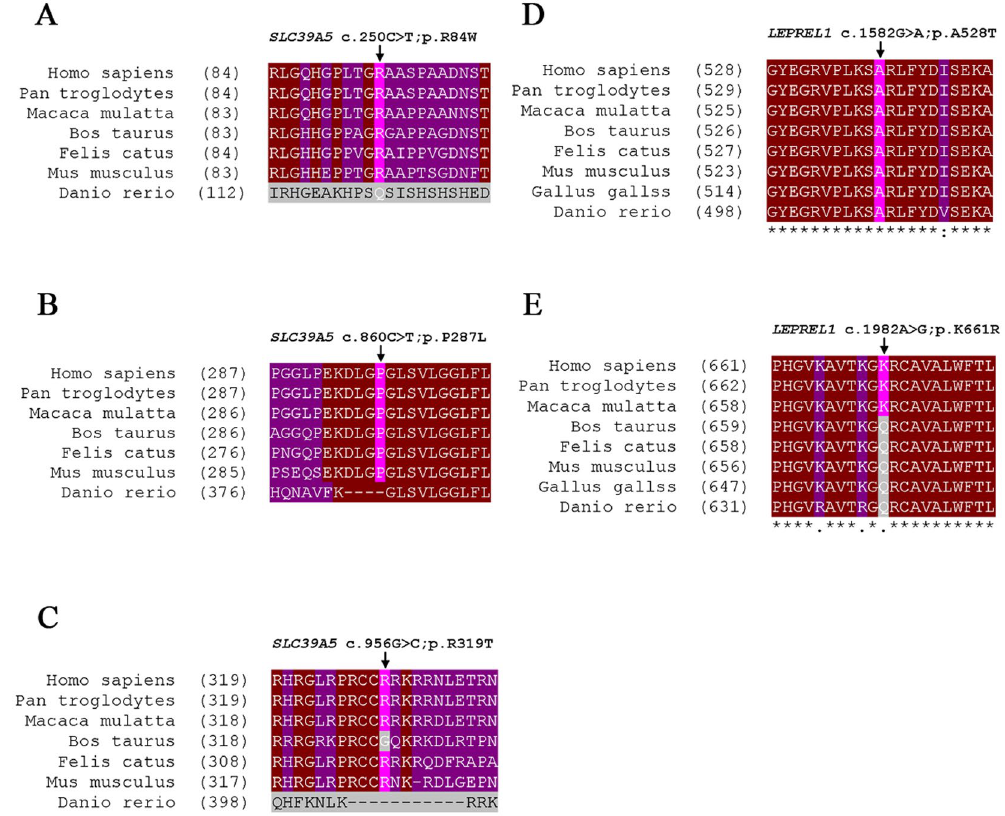
Figure 3. Conservation analysis revealed evolutionary conservation of the mutations. Clustal Omega results showing multiple alignments of the amino acids from different species. The arrow indicates the location of the mutations ( A – E